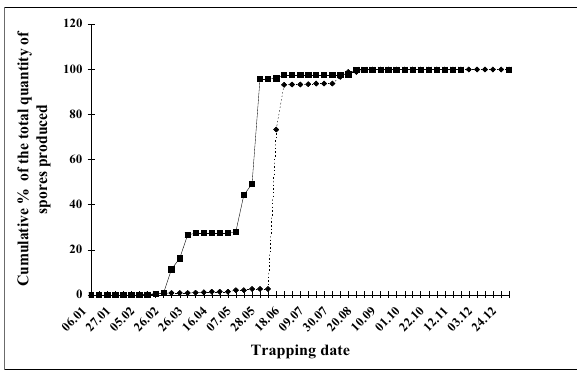
Fig. 3. Availability in 1997 (dotted line) and 1998 (solid line) of spores of Phaeoacremonium aleophilum ex- pressed as the cumulative percentage of the total quan- tity of spores